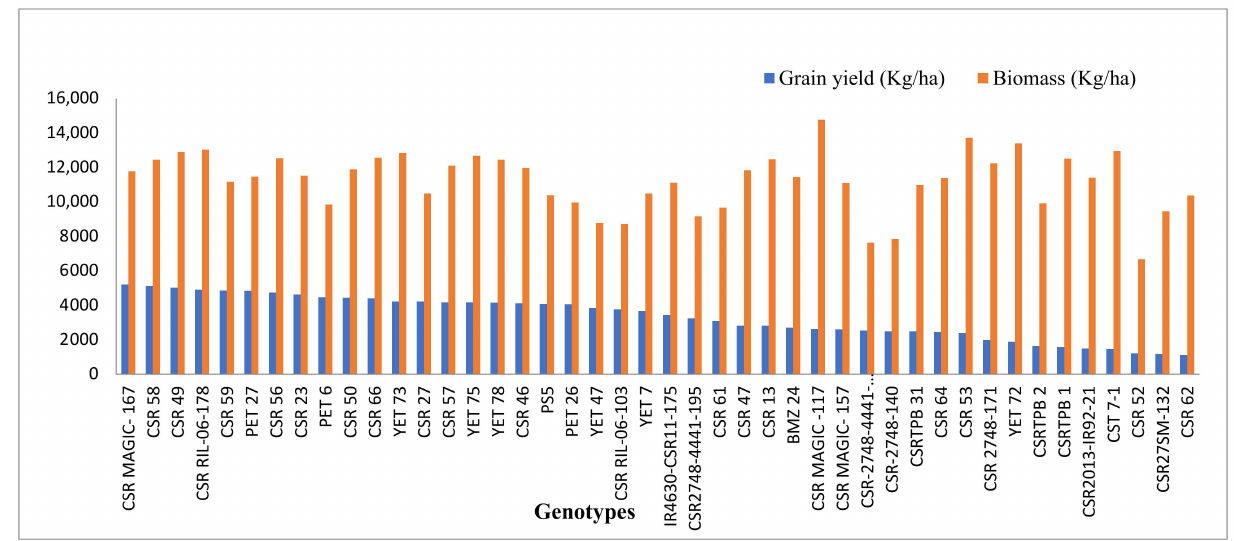
Figure 1. Grain yield and Biomass of rice genotypes in direct seeding